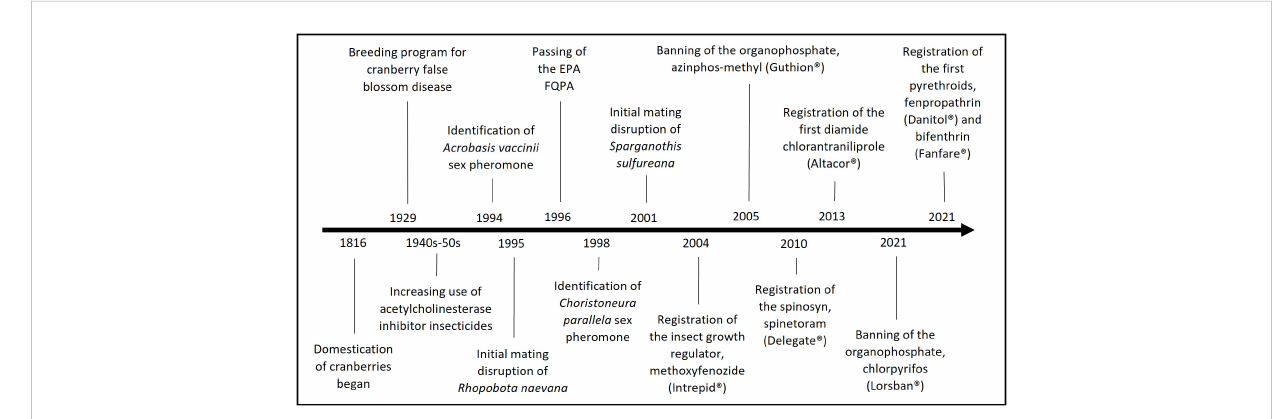
FIGURE 3 Timeline of some of the most important breakthroughs regarding cranberry insect IPM.